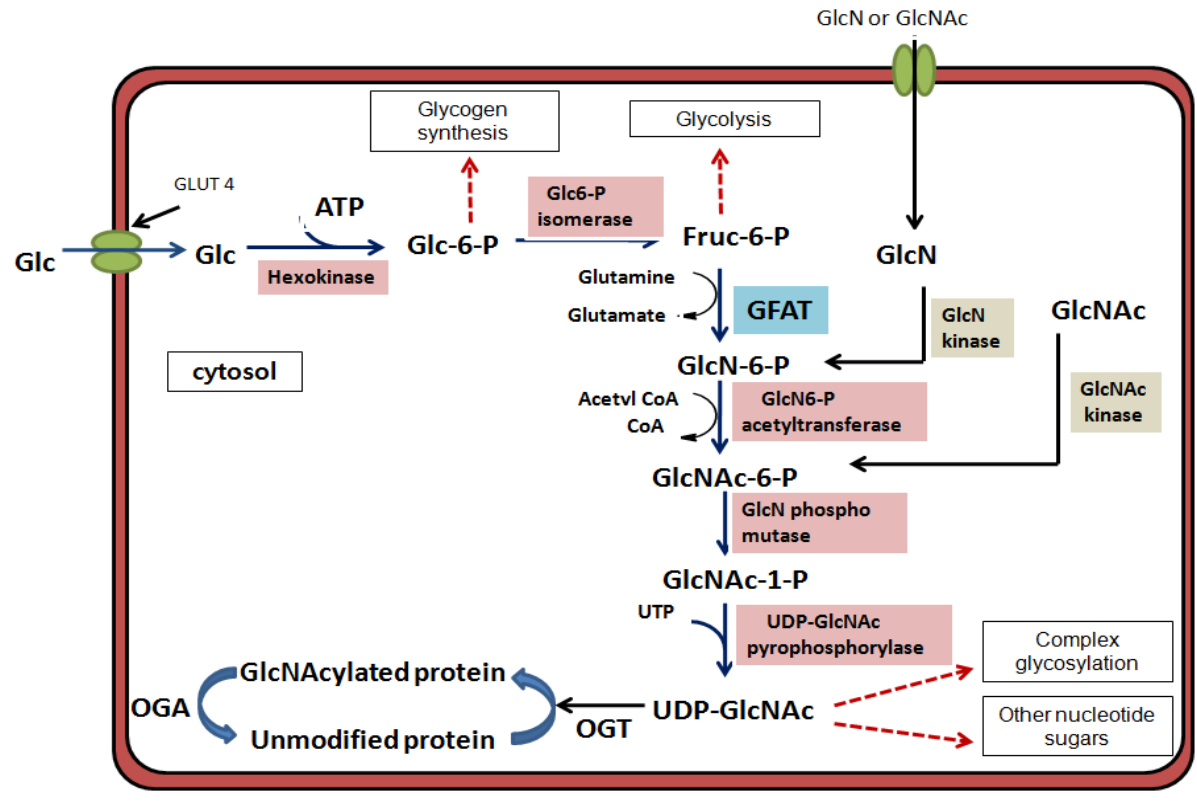
Figure 1. The hexosamine biosynthetic pathway